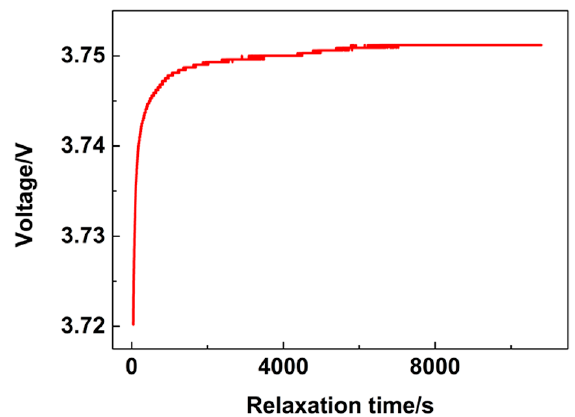
Figure 1. A schematic diagram of the voltage relaxation process of a LiCoO 2 /graphite battery after current interruption.